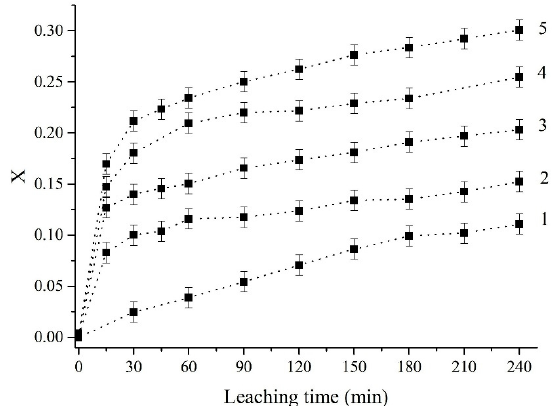
Figure 10. Dependence of the extraction degree on the time of the ilmenite leaching in 85 wt% sulfuric acid at a temperature of 100 °C. The mass ratio of ilmenite concentrate to NaF: 1:0 (1); 1:0.25 (2); 1:0.5 (3); 1:0.75 (4); 1:1 (5).